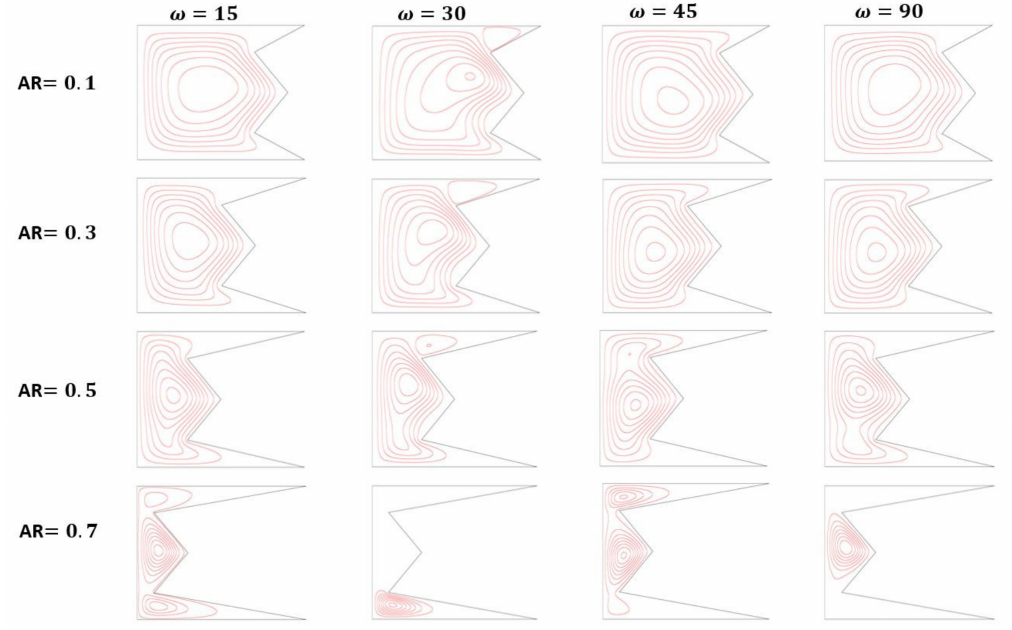
Figure 18. Streamlines for di ff erent angles of inclination ω and aspect ratios with Ra = 10 5 , Ha = 15, Da = 10 − 2 , ϕ = 0.04, Fr = 0.75 and q ∗ =